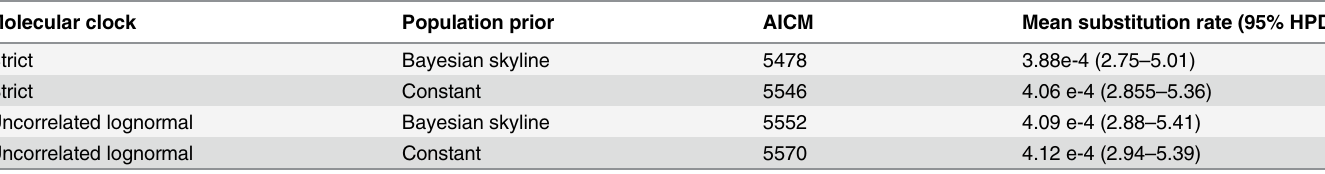
Table 1. Assessment of model fi t using a modi fi ed Akaike Information Criterion (AICM) for RABV partial nucleoprotein sequences. Molecular clock